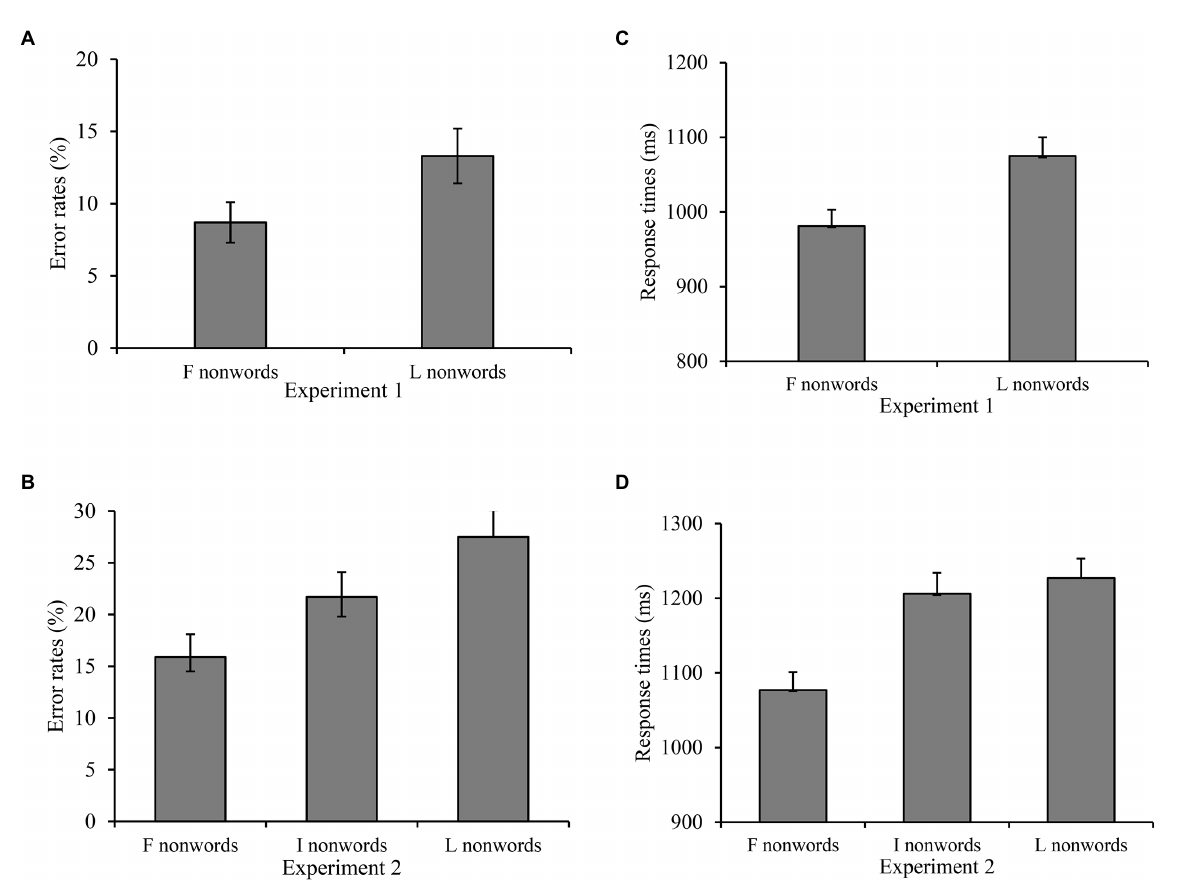
FIGURE 1 Error rates (A,B) and RT (C,D) in Experiments 1 and 2. The SE of mean is represented by the error bars. F pseudowords, first-two-character transposed pseudowords; I pseudowords, inner-two-character transposed pseudowords; and L pseudowords, last-two-character transposed